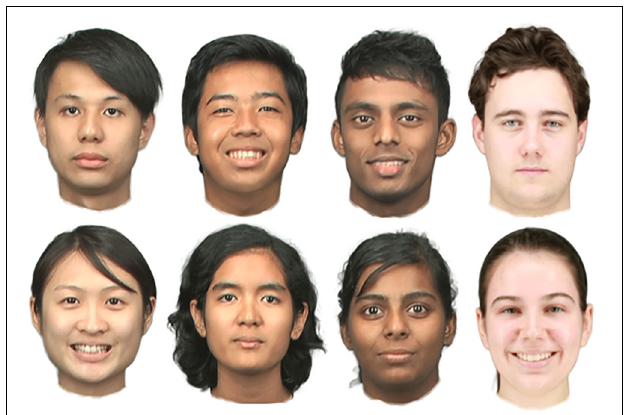
FIGURE 3 | Examples of whole-face stimuli with smiling and neutral expressions used in Experiment 2. Each column shows a male and a female face for each race group (Malaysian–Chinese, Malaysian–Malay, Malaysian–Indian, and Western–Caucasian, respectively). The individuals depicted in this figure gave written informed consent to the publication of their